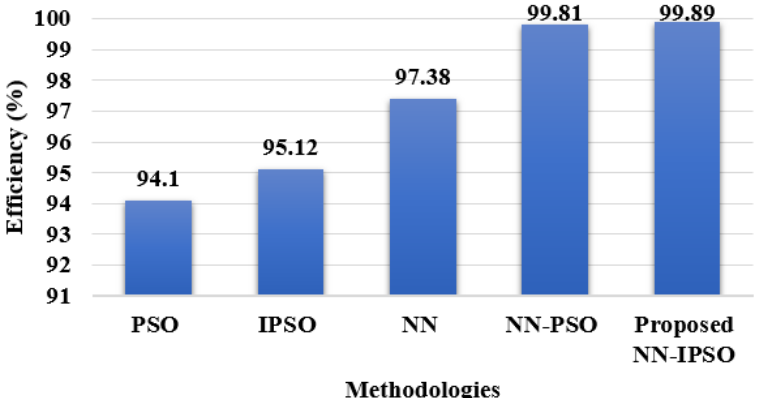
Figure 7. Performance analysis of efficiency.